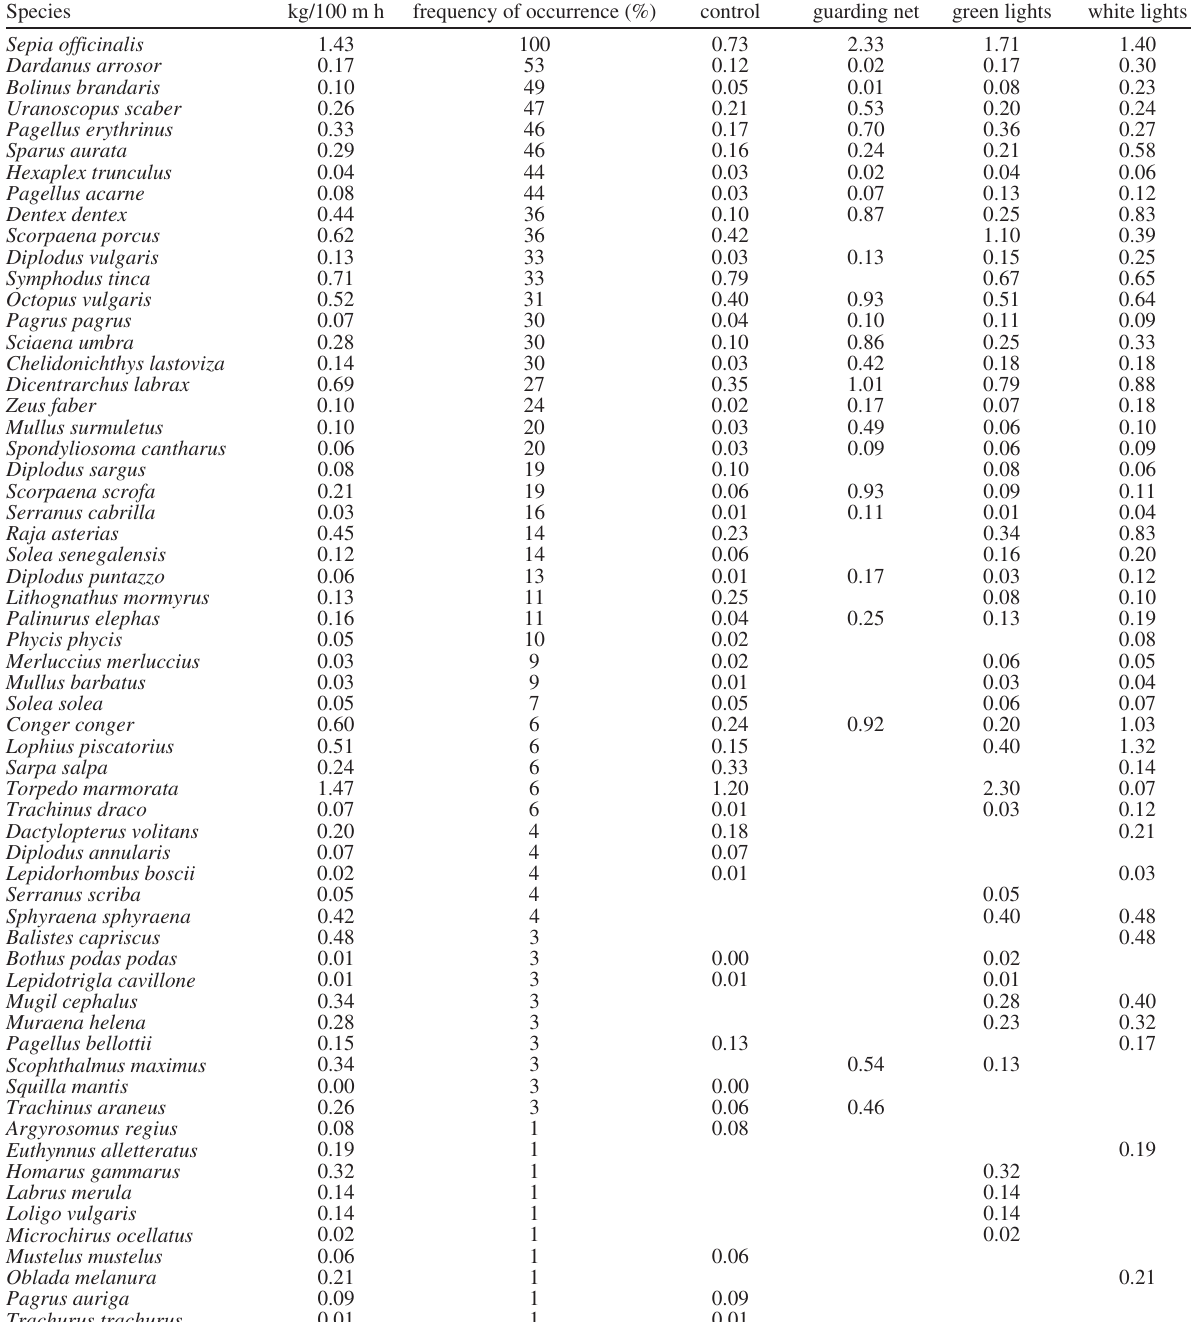
Table 1. – Standardized catch (kg/100 m h) and frequency of occurrence of commercial species caught by each net configuration adopted in this study. The 20 most important species in weight are highlighted in bold face. Species kg/100 m h frequency of occurrence (%) control guarding net green lights white lights Sepia